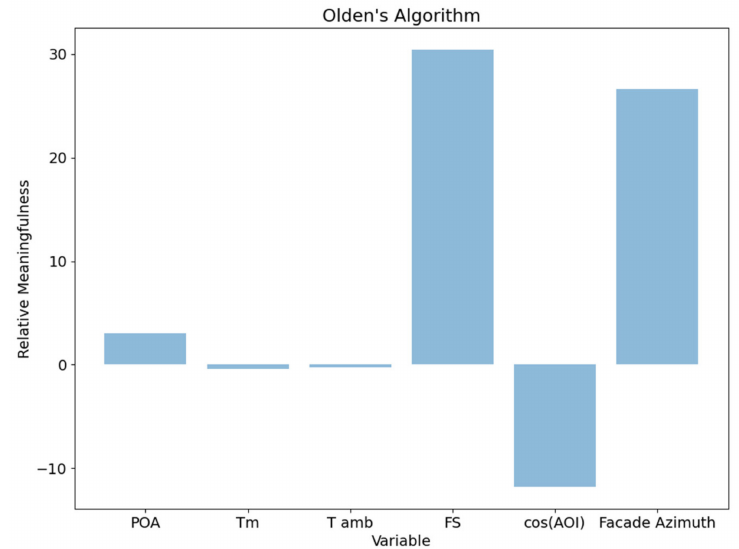
Figure 6. Relative importance of the input variables of the ANN